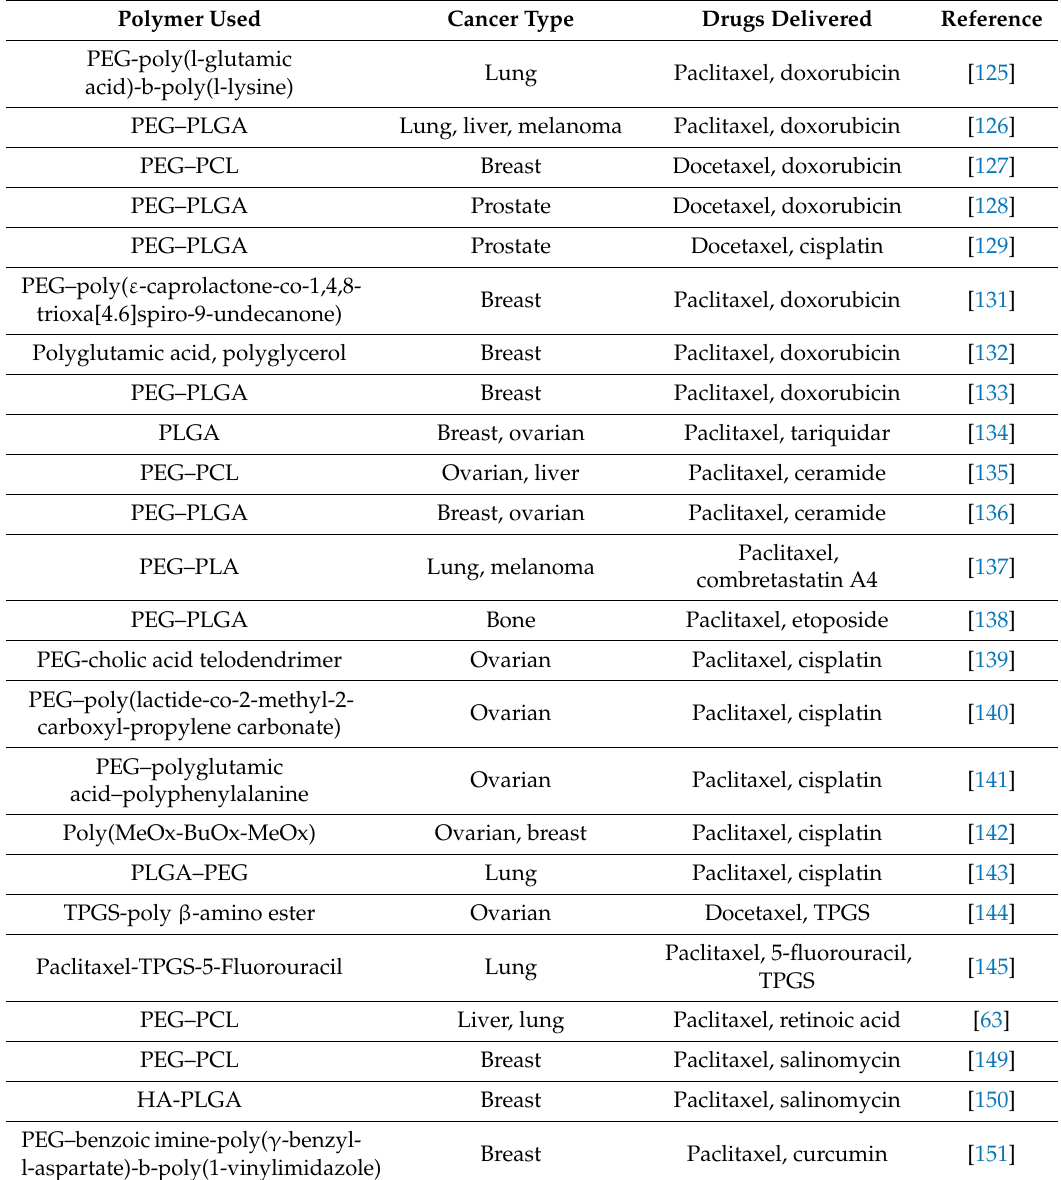
Table 1. Summary of studies using polymeric nanoparticle systems to deliver paclitaxel-based combination